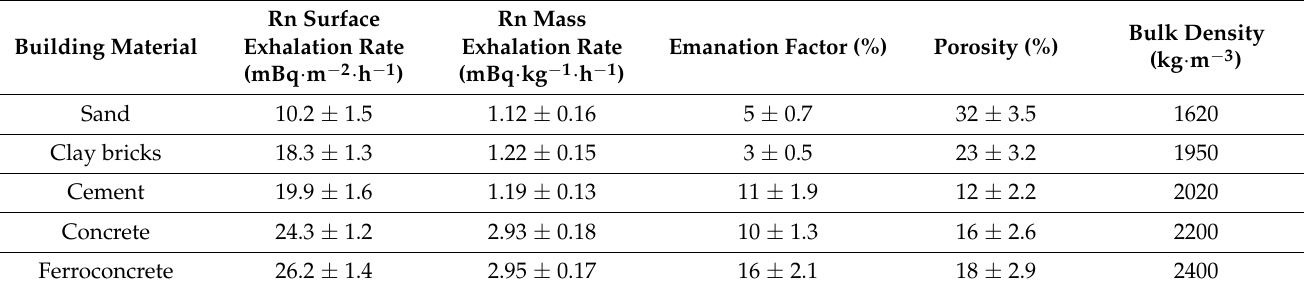
Table 1. Radon surface and mass exhalation rates and other parameters of studied building materials (M.V. ± σ ). Rn Surface Exhalation Rate Building Material